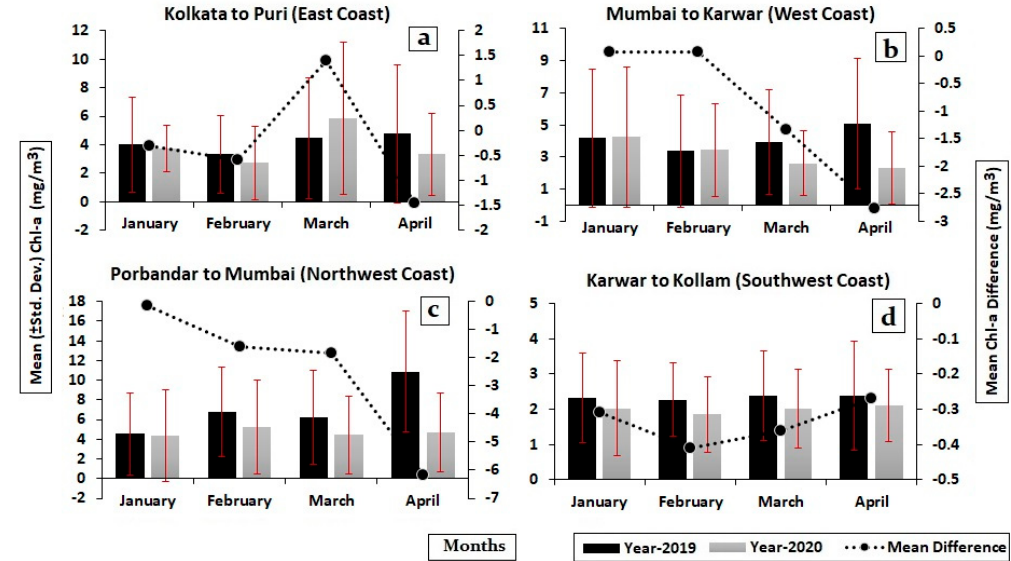
Figure 5. Comparison of satellite derived monthly mean chlorophyll-a concentration for four coastal regions ( a ) Kolkata to Puri (East Coast), ( b ) Mumbai to Karwar (West Coast), ( c ) Porbandar to Mumbai (Northwest Coast), and ( d ) Karwar to Kollam (Southwest Coast). Region-wide chlorophyll-a levels show the largest decline the most urbanized coastal zones (West and Northwest coast) during the lockdown (April 2020). The vertical bars represent standard deviation from mean values ( ± standard deviation). Large deviations are because of the large coastal area covered in the regional transect analysis.